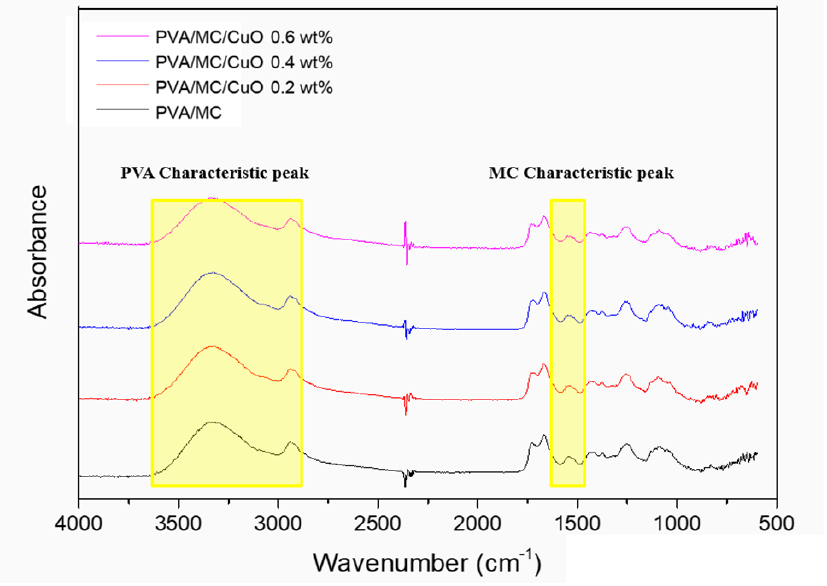
Figure 3. FTIR spectra of PVA/MC, PVA/MC/CuO 0.2 wt.%, PVA/MC/CuO 0.4 wt.%, and PVA/MC/CuO 0.6 wt.%.